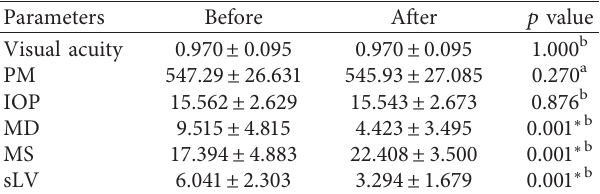
Table 3: Perioperative comparison of balance function